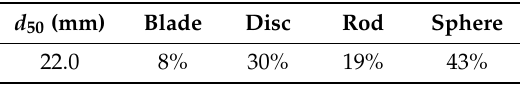
Table 3. Zingg’s shape